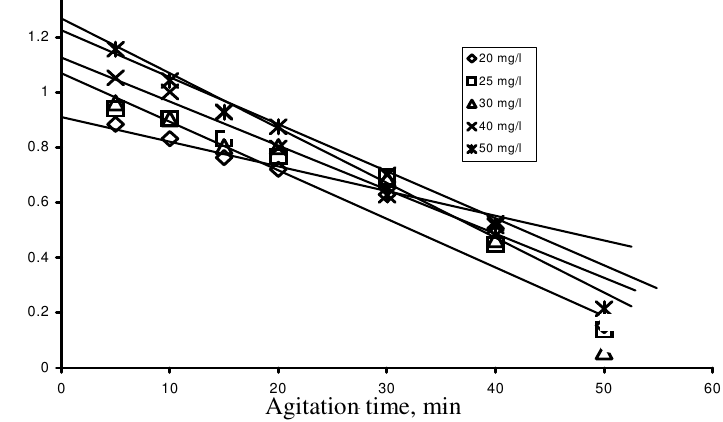
Figure 3. Lagergren plots for Cu(II) adsorption plots of log (q